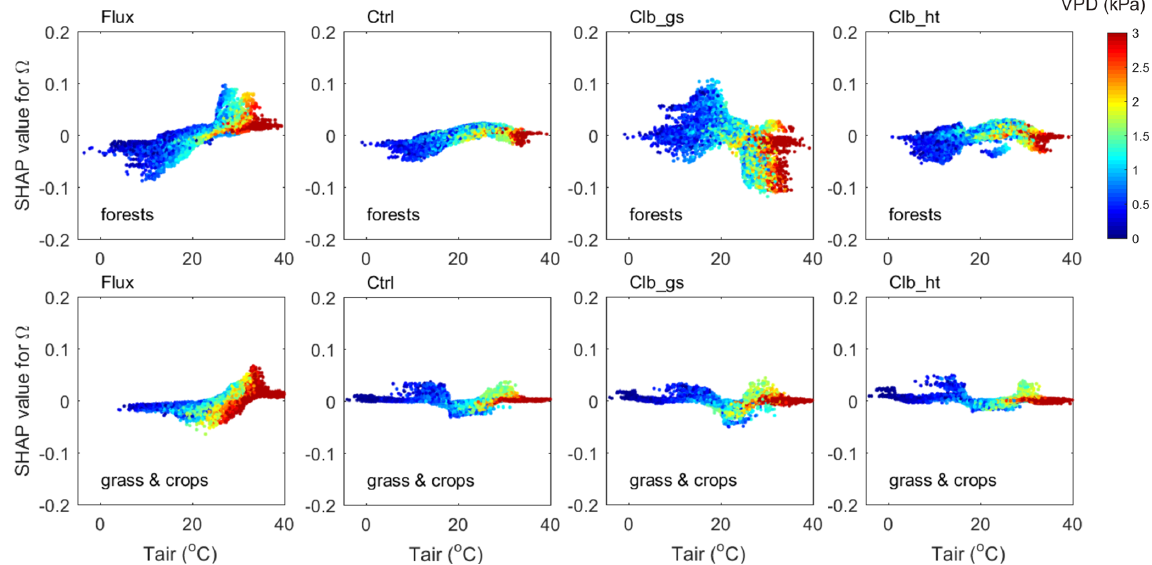
Figure 7. The interaction between VPD and air temperature in controlling (cid:127) (contribution of temperature) in forests (top) and in grasslands and croplands (bottom). The y axis is the SHAP value of Tair for (cid:127) , colors indicate the VPD of each data point.